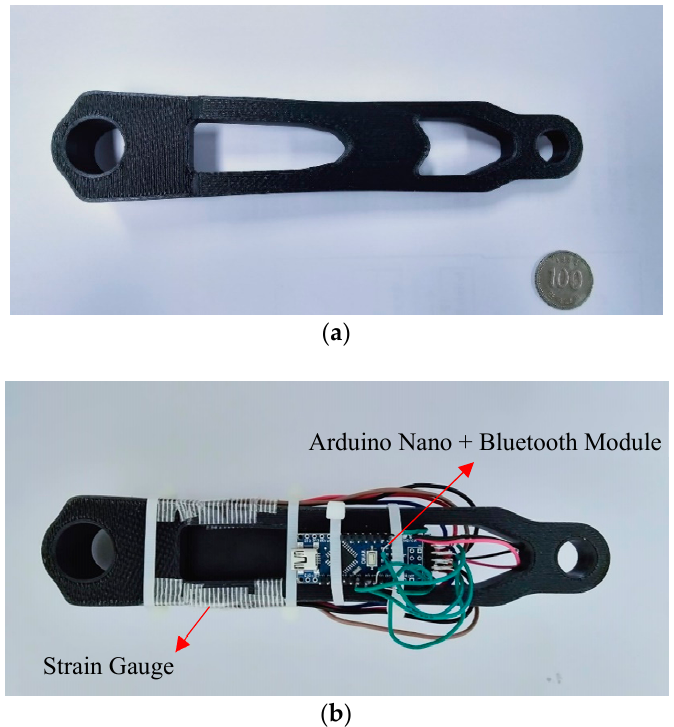
Figure 18 . (a) Three-dimensional (3D) printing result, (b) strain gauge, and Arduino installation.